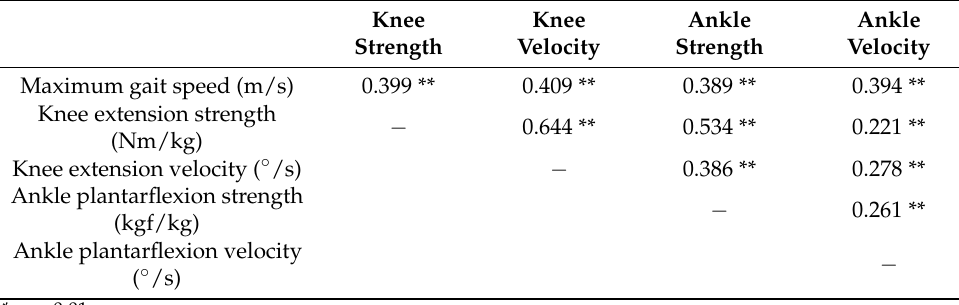
Table 2. Correlation between gait speed and lower limb functions.